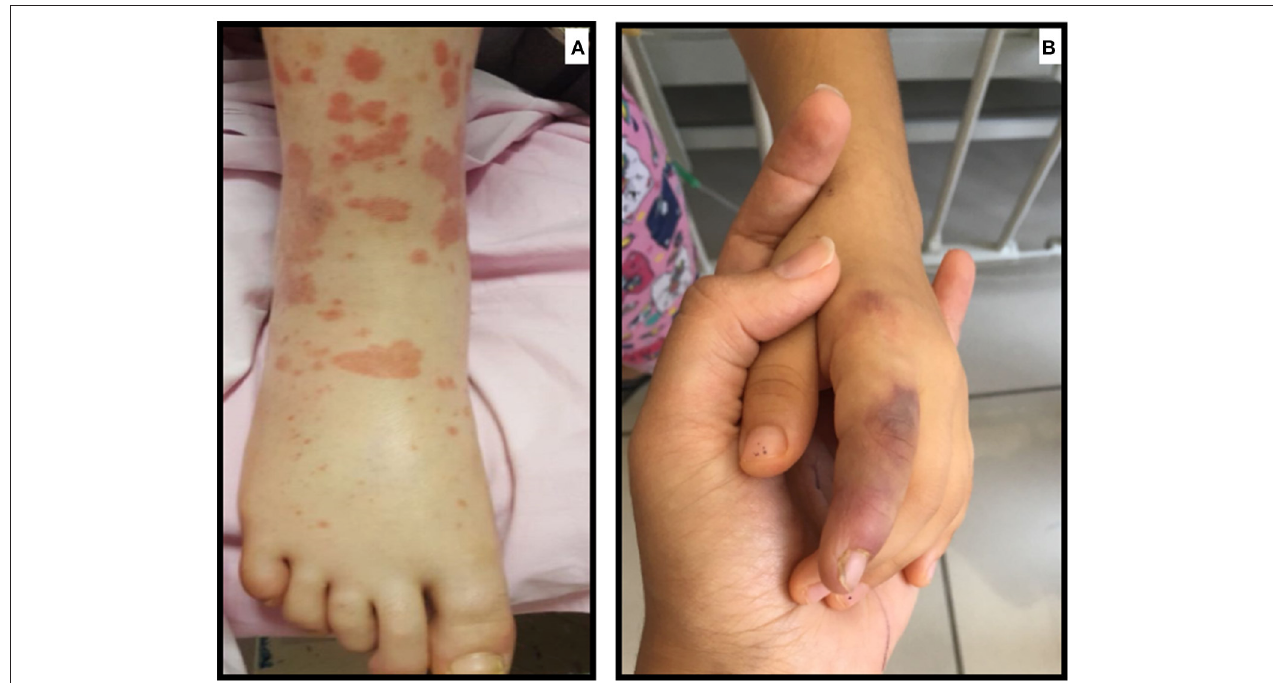
FIGURE 2 | (A) Atypical purpuric rash in a patient with FMF who developed IgAV/HSP (B) Ischemic lesion due to medium-size vessel involvement in a child with FMF who developed PAN.